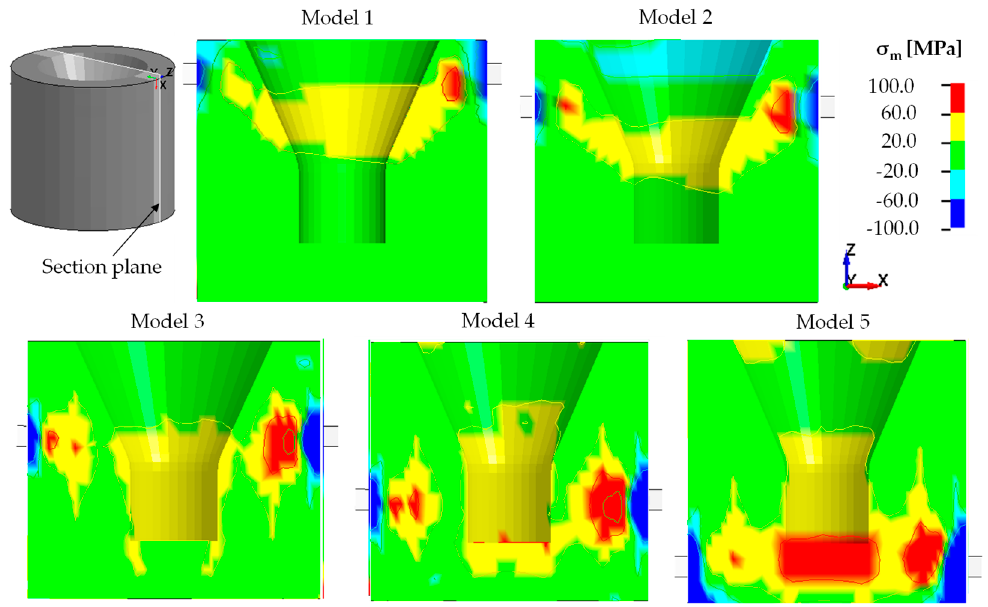
Figure 23. Distribution of the compressive and tensile stresses in the tool (along the cross-section).